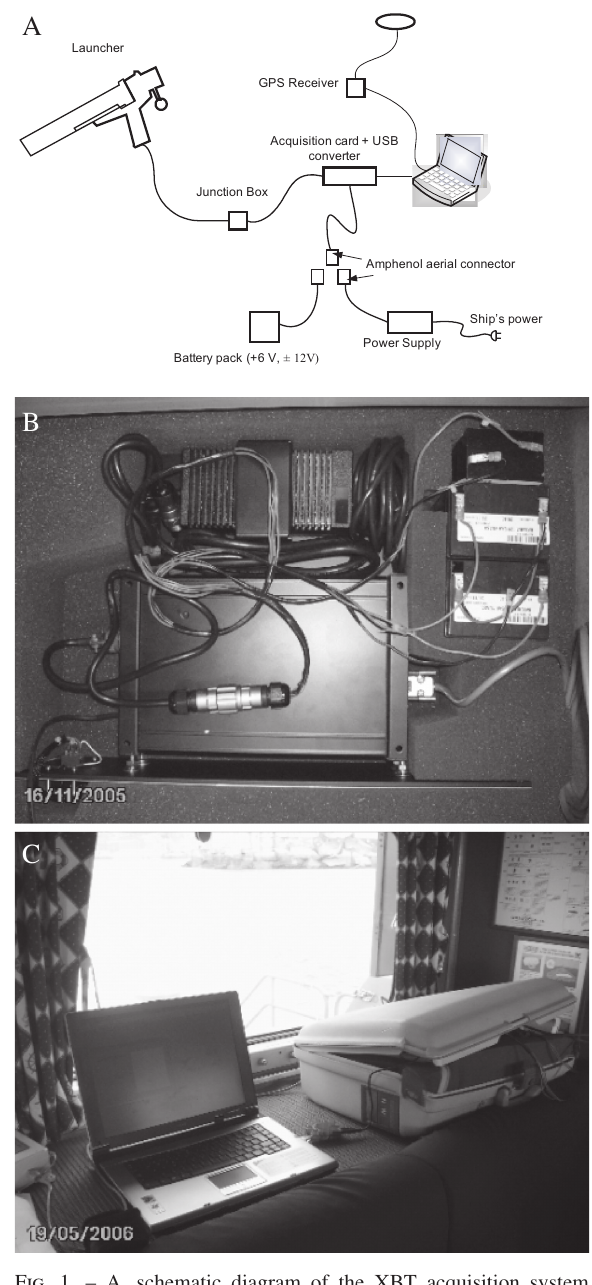
Fig . 1. – A, schematic diagram of the XBT acquisition system adapted to work autonomously; B, detail of the aerial amphenol connectors to the battery pack; C, the suitcase containing the desk system and the laptop used in the